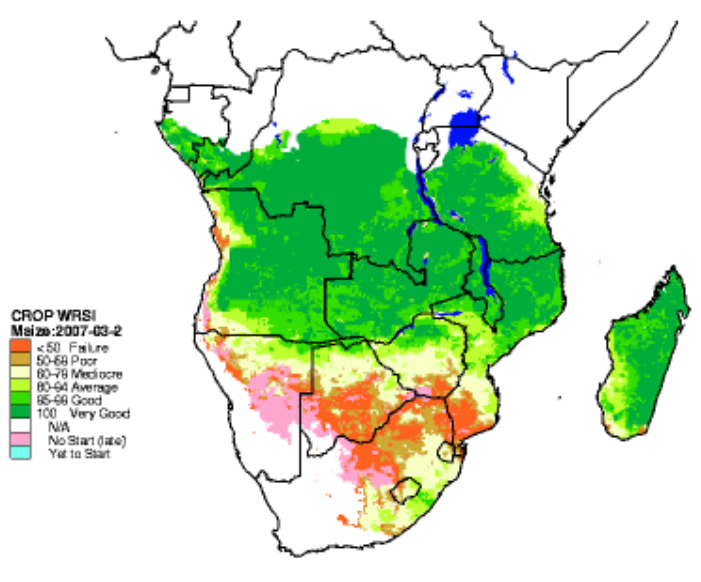
Figure 12. Spatial distribution of maize crop water requirement satisfaction index (WRSI) for southern Africa as of the 2 nd dekad of March